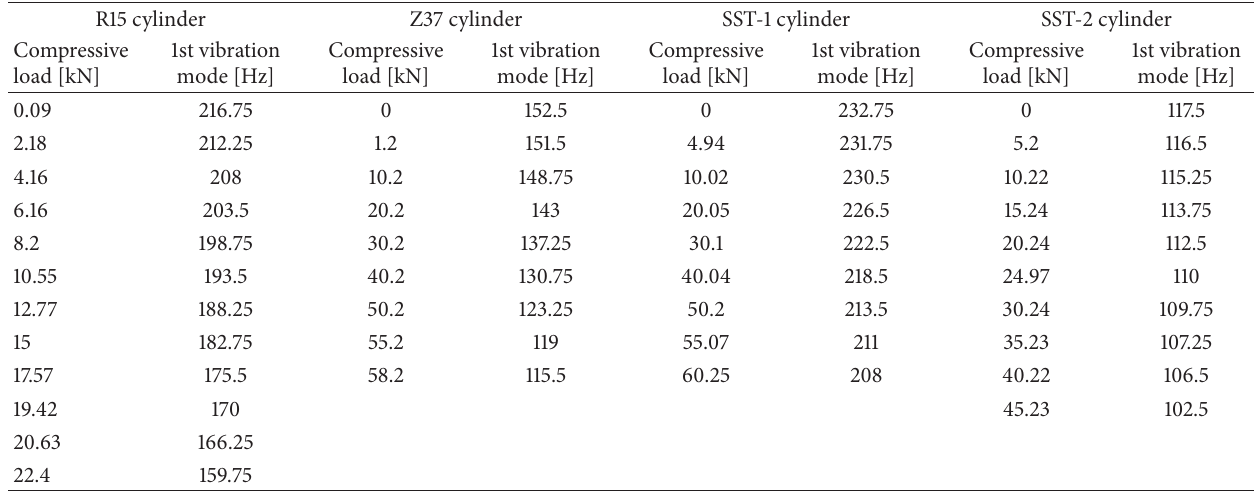
Table 5: Variation of the 1st vibration frequency with the applied load.